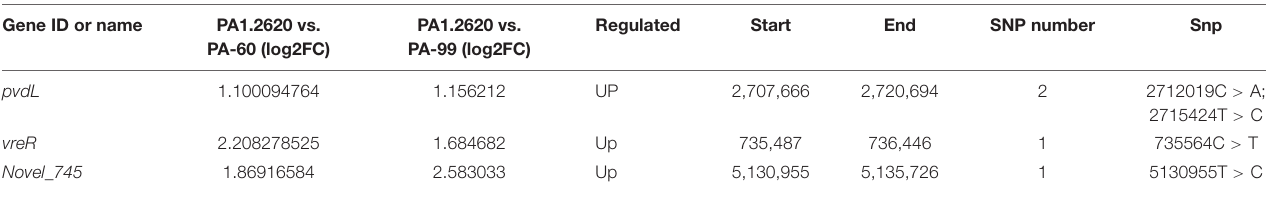
TABLE 4 | SNP change of the co-expressed sRNA target genes of HL